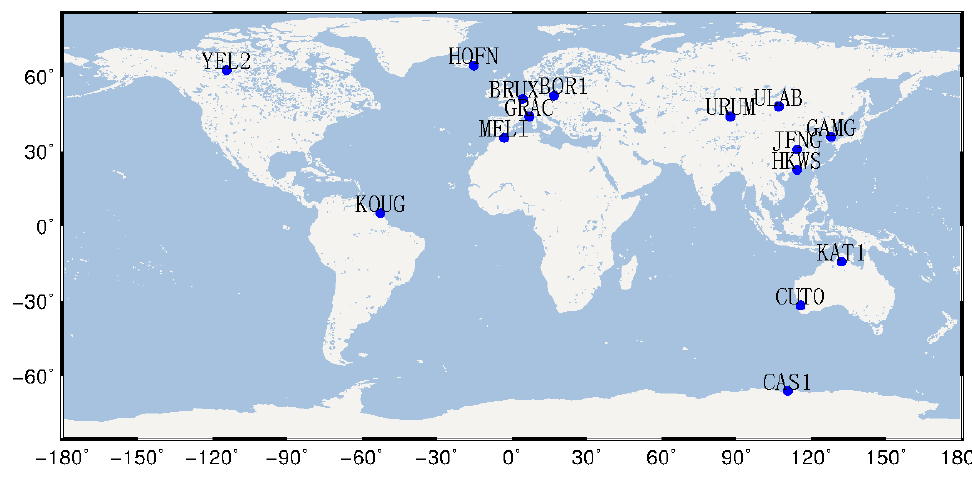
Figure 1. Information of MGEX continuous tracking stations.